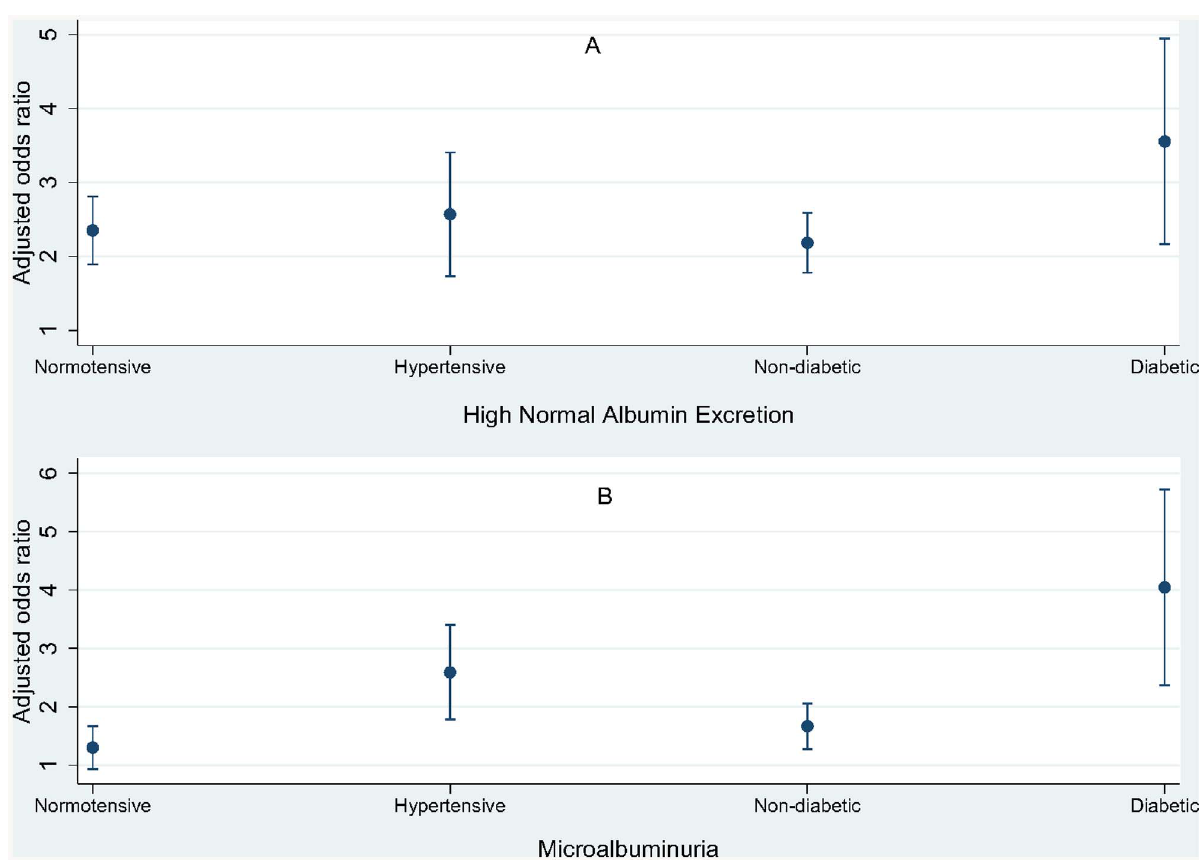
Figure 1. Association between and water-pipe smoking and albuminuria based on hypertension and diabetes mellitus categories. All estimates were adjusted for age, sex, BMI and social